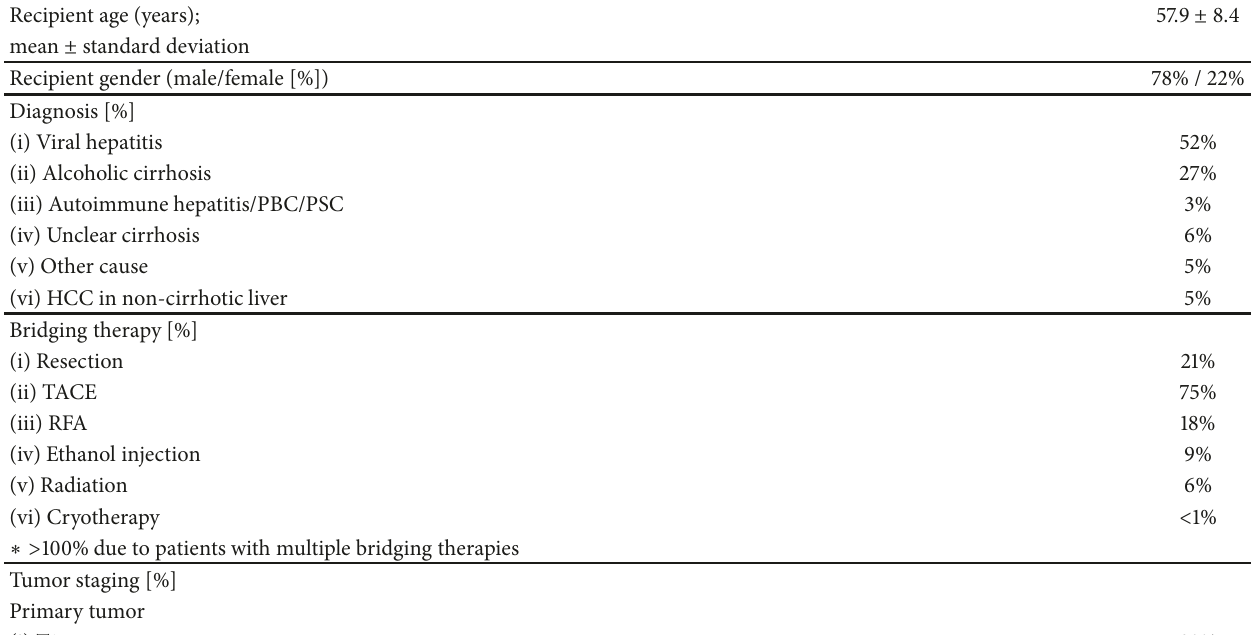
Table 1: Patient and tumor